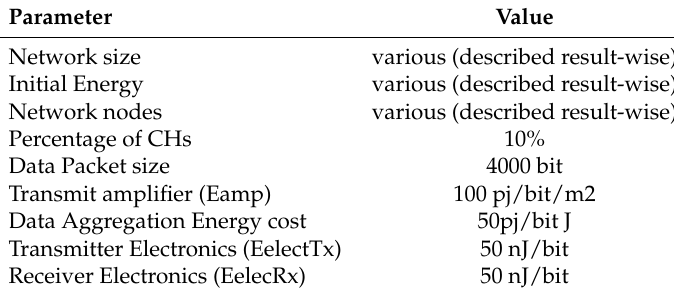
Table 2. General simulation